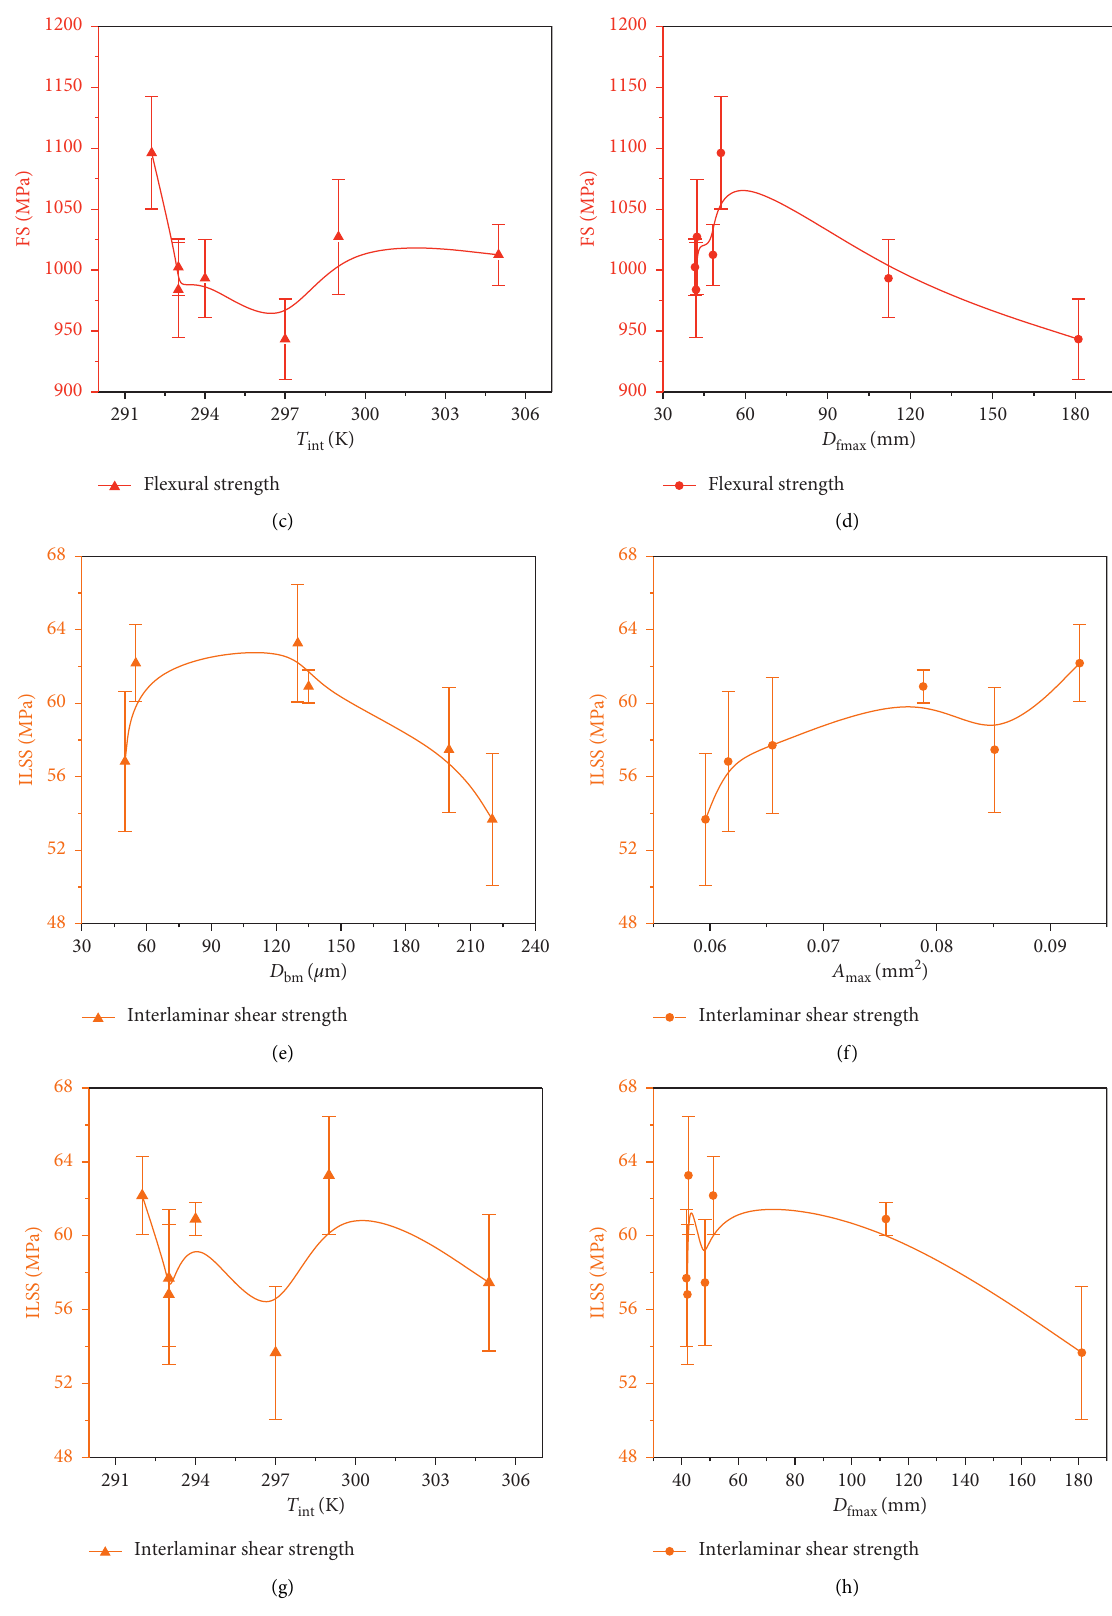
Figure 9: Relationship between bubble characteristic parameters and mechanical properties: (a) FS and bubble displacement. (b) FS and maximum cross-sectional area of the bubble. (c) FS and internal lowest temperature of the bubble. (d) FS and maximum deformation of the fiber. (e) ILSS and bubble displacement. (f) ILSS and maximum cross-sectional area of the bubble. (g) ILSS and internal lowest temperature of the bubble. (h) ILSS and maximum deformation of the